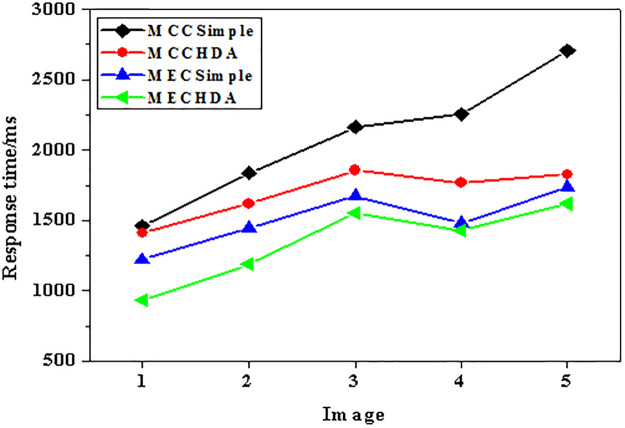
The response time of each architecture under the mobile data network.